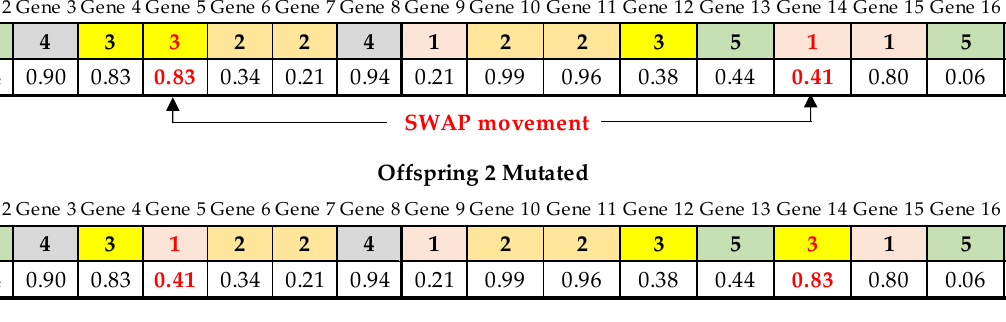
Figure 8. Mutation operator based on SWAP movements. Step 7. After applying the crossover or mutation operator, infeasible offspring may be generated because one or more jobs do not have assigned the number of operations they require, so a job j appears more or fewer times in the offspring than the number of operations it must perform. As shown in Figure 9, the repair mechanism randomly ex ‐ changes one of the remaining operations for a missing one.